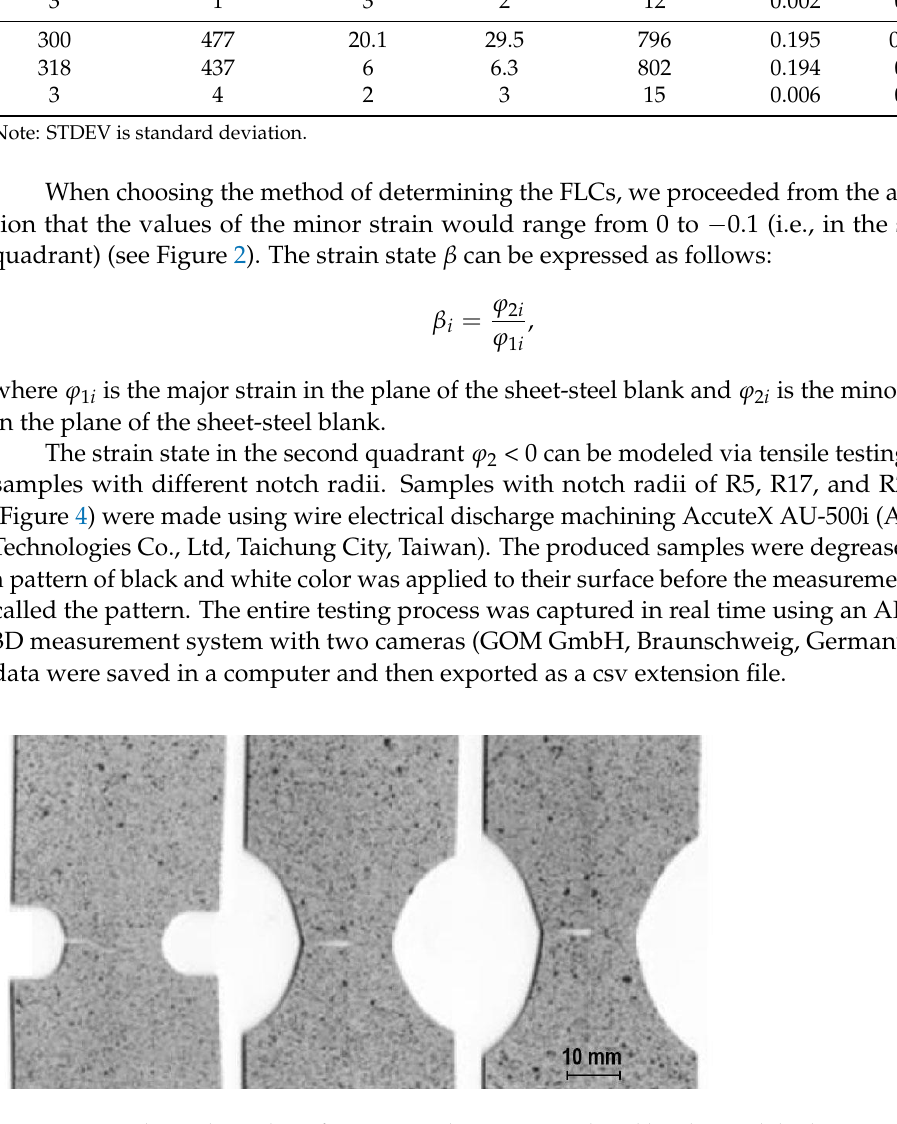
Figure 4. Samples with notches of R5, R17, and R25 mm produced by electrical discharge machining after strain.